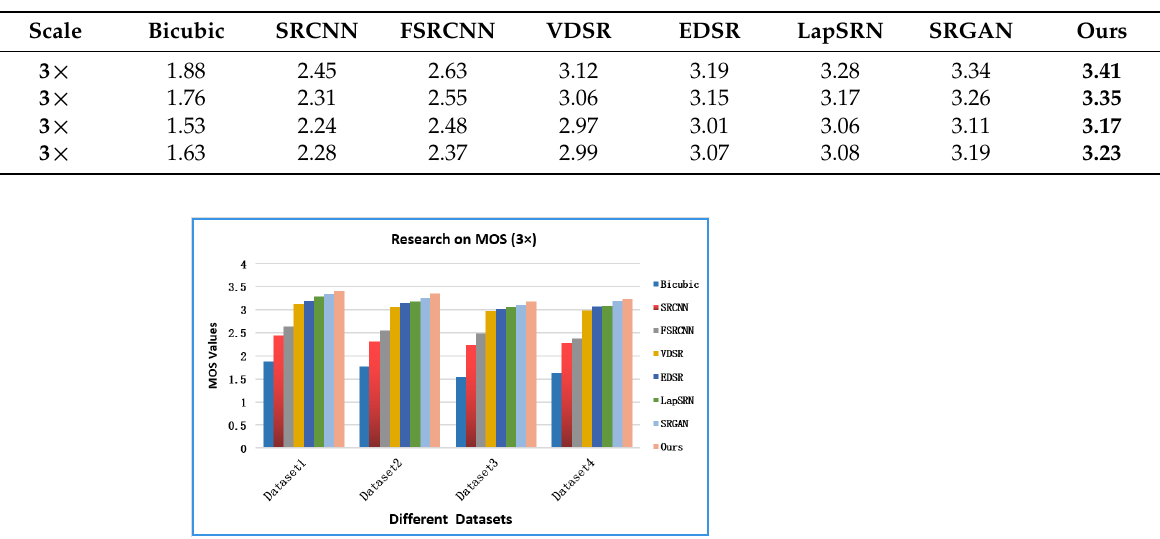
Table 4. Average MOS values with different algorithms on Dataset 1, Dataset 2, Dataset 3, and Da- taset 4.